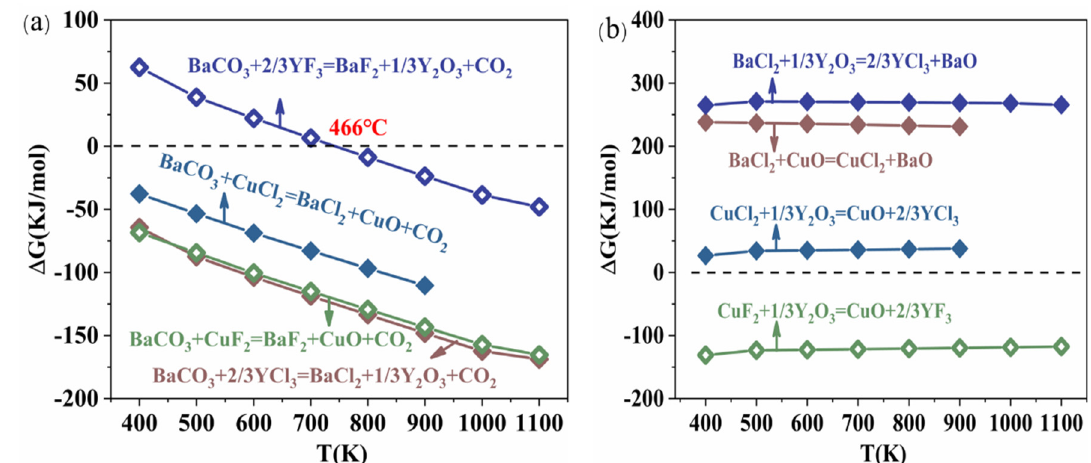
Figure 7. Gibbs free energy of each reaction formula: ( a ) Gibbs free energy change of BaCO 3 removal reaction; ( b ) further reaction between products.